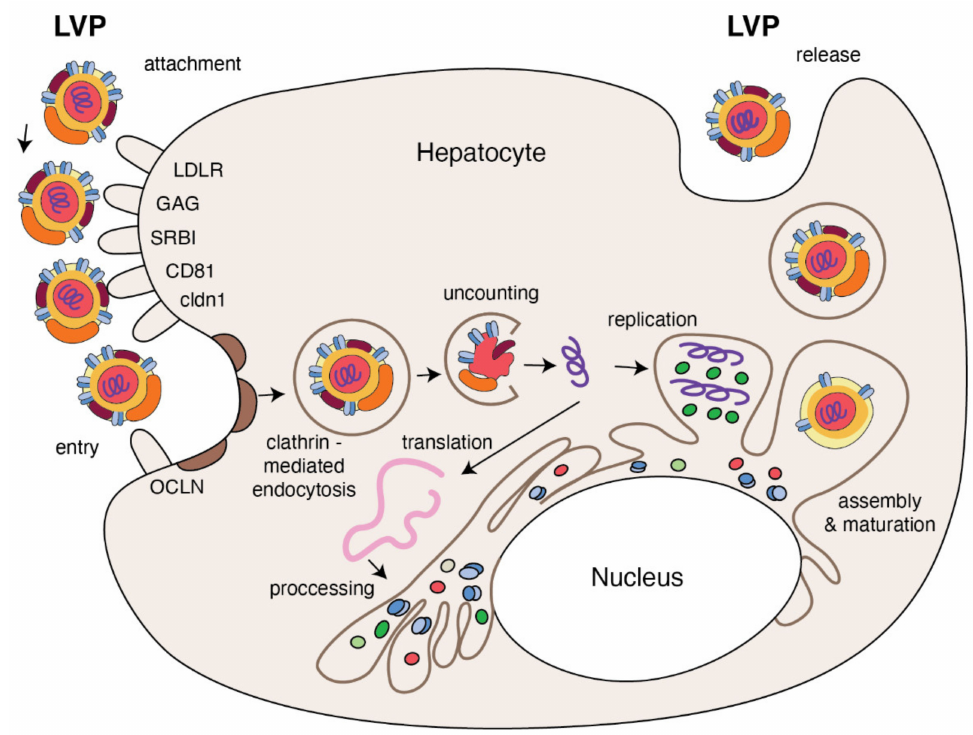
Figure 3. The replication cycle of HCV. Lipo-viral particle binds to the host cellular receptors such as LDLR, SRB1, CD81, claudin1 and others (please refer to the main text). Following attachment, the virus enters the target cell via clathrin- mediated endocytosis. Upon entry, HCV RNA is released into the cytoplasm and is directly translated via an IRES at the ER. A polyprotein precursor is then processed by both viral and host proteases. Non-structural viral proteins and host factors form a membranous web and replication complexes that are used for synthesis of multiple HCV RNA copies. Viral progenies are packed, forming nucleocapsid that is enriched by viral envelope glycoprotein. The access to the lipoprotein pathway provides conditions for incorporation of neutral lipids and apolipoproteins and formation of the mature lipo-viral particle released from hepatocytes by